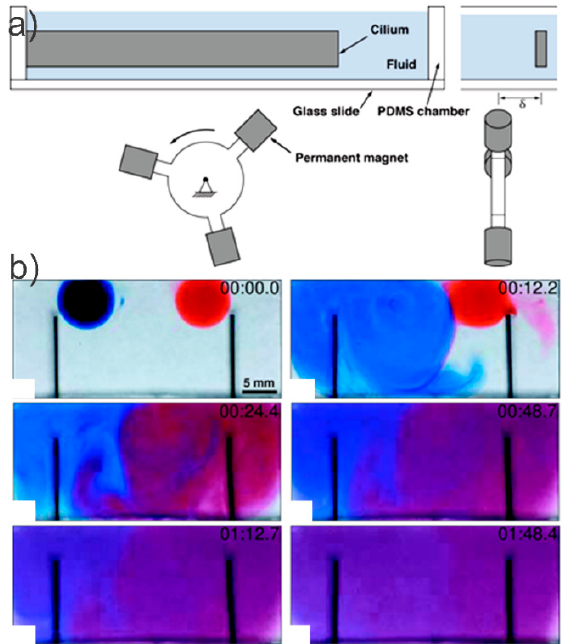
Figure 4. The experimental setup and results of [103] for individually controlling two cilia in a fluid chamber. ( a ) The setup configuration and ( b ) time lapse images with the best performed alternate pattern cilia beat. Reproduced with permission from [103], published by the ASME, 2017.